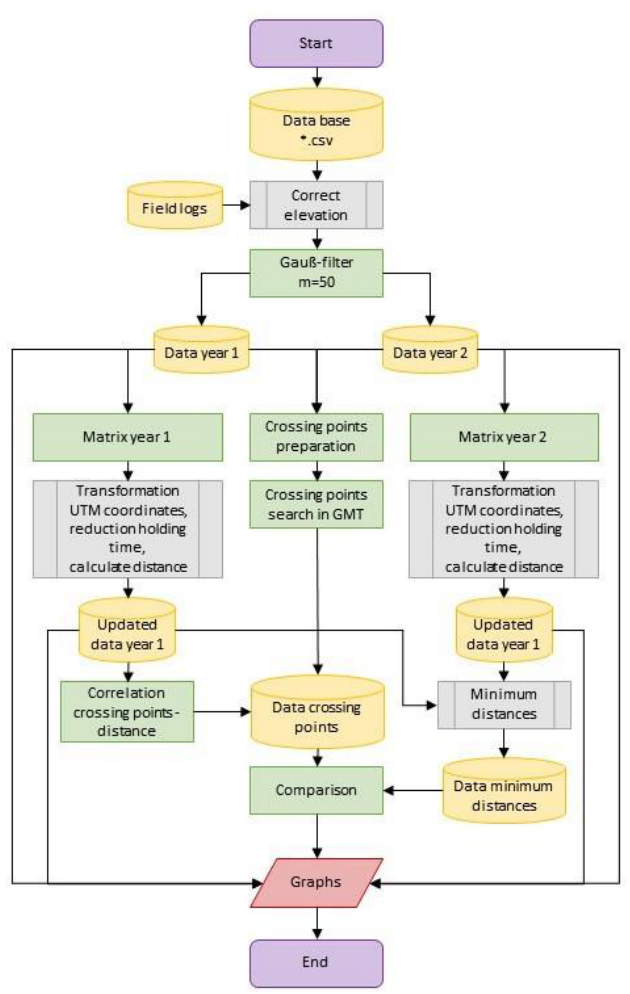
Figure A1. Program flow for kinematic analysis.